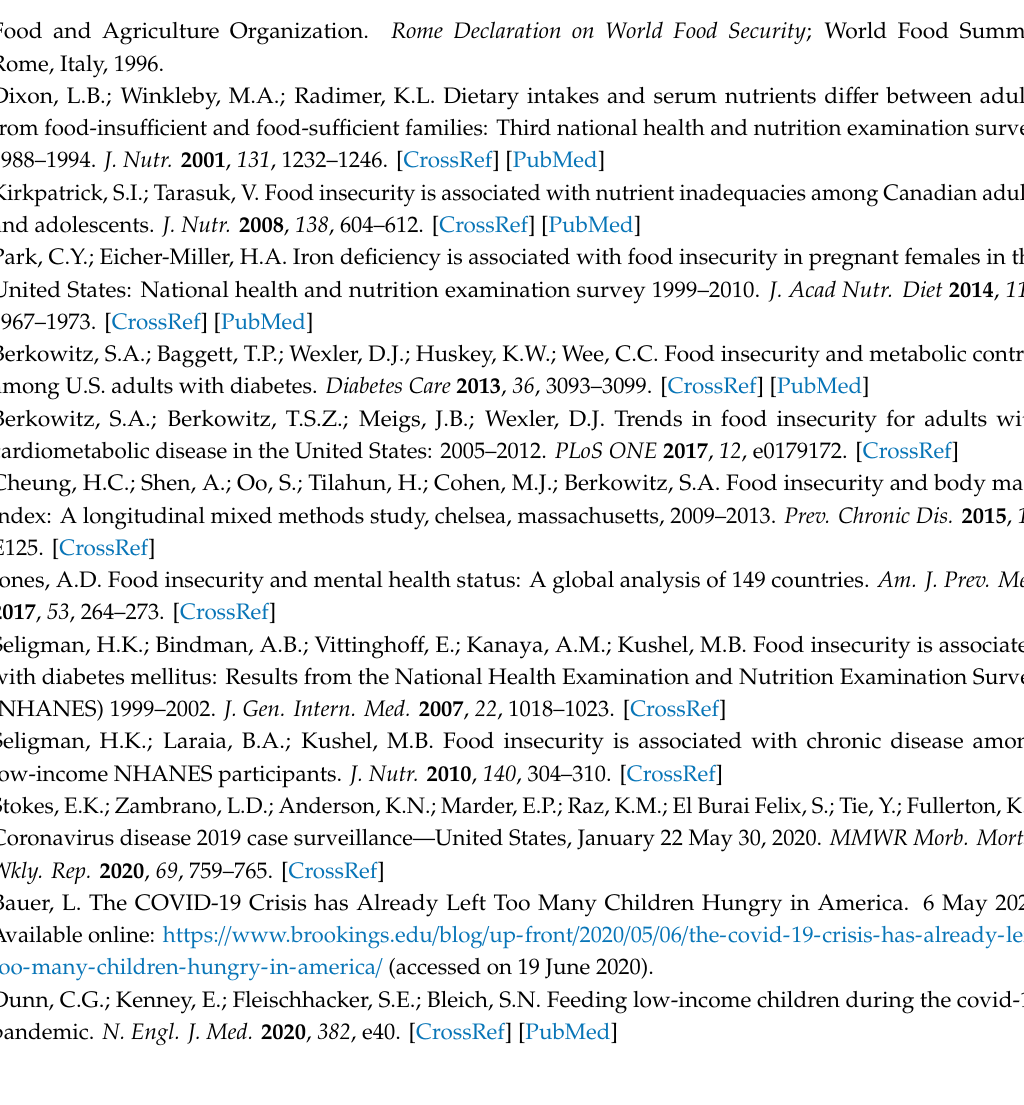
Table S2: Frequency of responses to questions on the 6-Item USDA Food Security Survey Module ( n = 319). Table S3: Predictors of food insecurity during the COVID-19 pandemic using unweighted